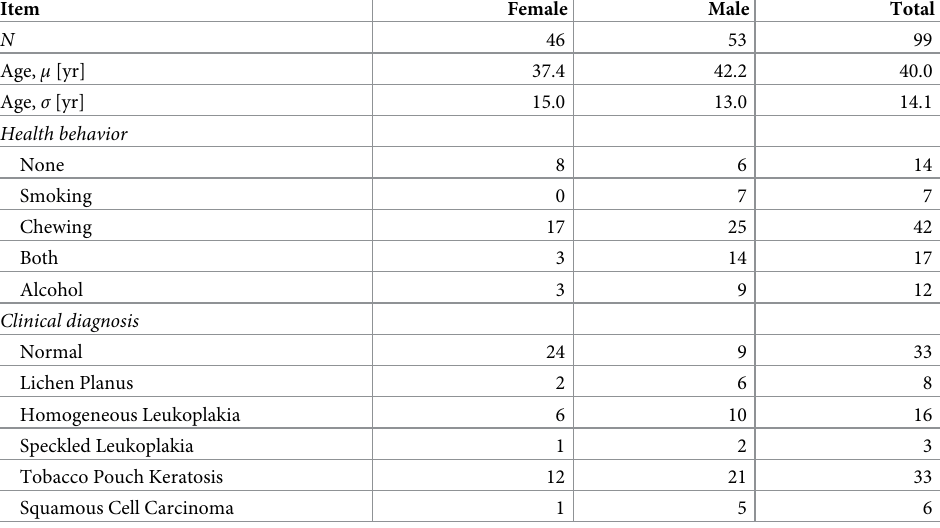
Table 3. Study participant demographics for the image pairs used in CNN classification. Values are provided as the N of each category except for age in units of years. The Both health behavior represents the combination of both smok- ing and chewing. Health behavior was not collected for all participants. Item